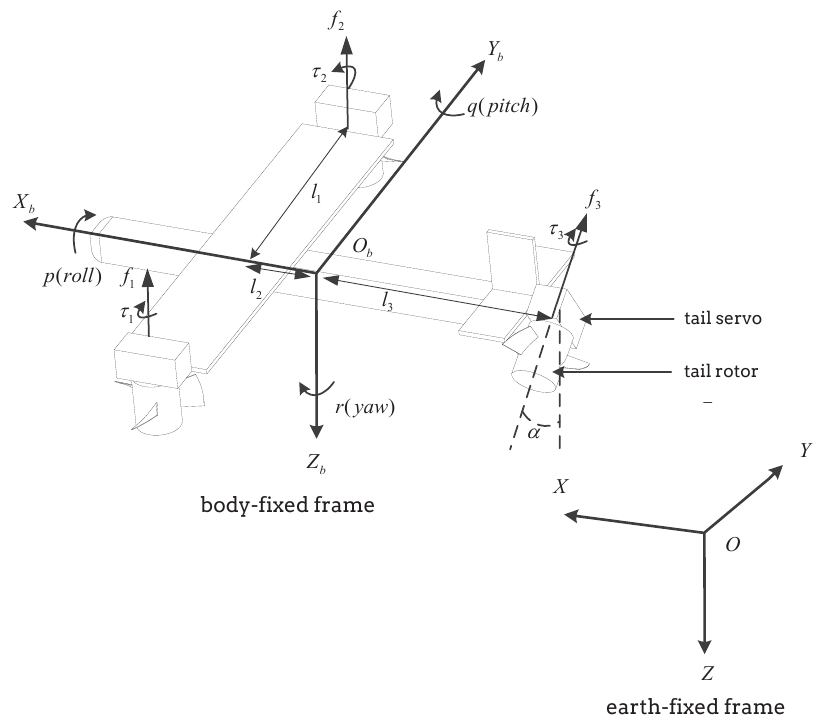
Figure 1. Configuration of NTAUV with Earth-fixed and body-fixed